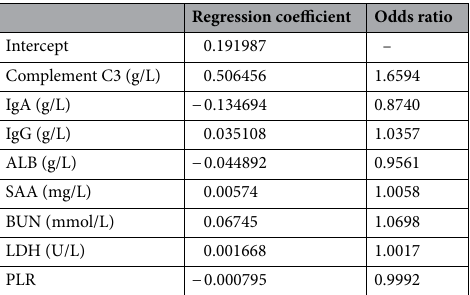
Table 4. Multivariable logistic regression models for the outcome “severe versus mild” in all patients irrespective of age selected using the AIC criterion and forward selection.